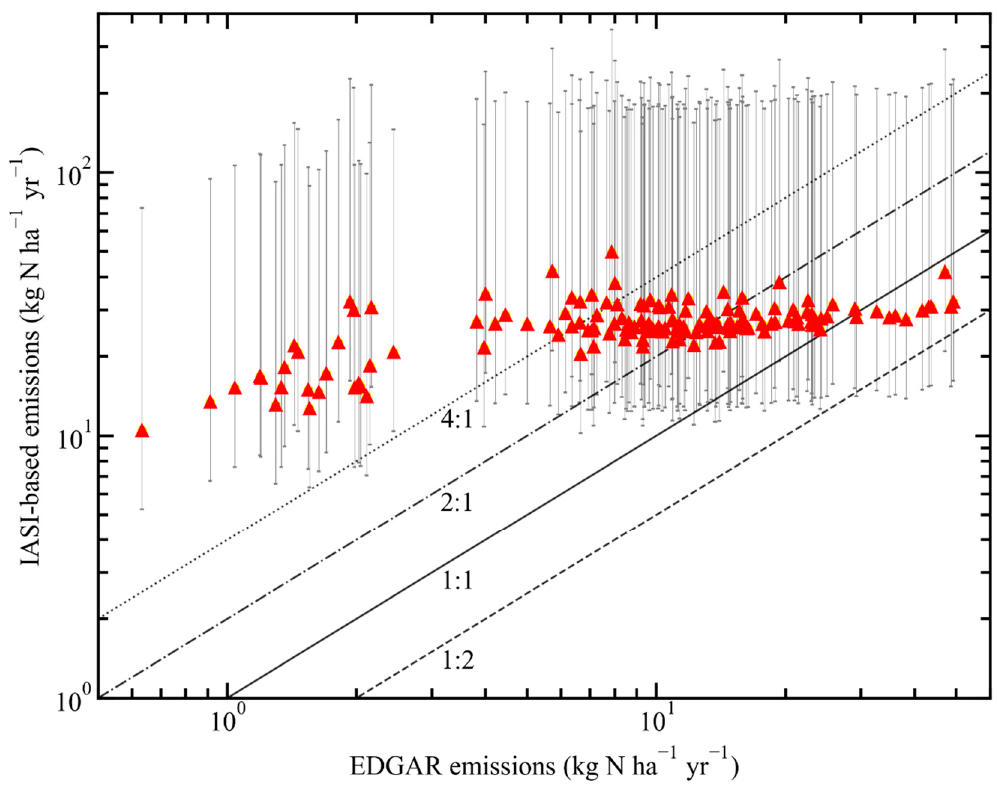
Figure 5. Comparison of IASI-based NH 3 emissions with EDGAR. The red triangles represent IASI-based emission estimates compared with EDGAR emissions at county level. The dotted, dash-dotted, solid and dashed lines represent the ratios of EDGAR emissions to IASI-based emissions of 4:1, 2:1, 1:1 and 1:2, respectively.